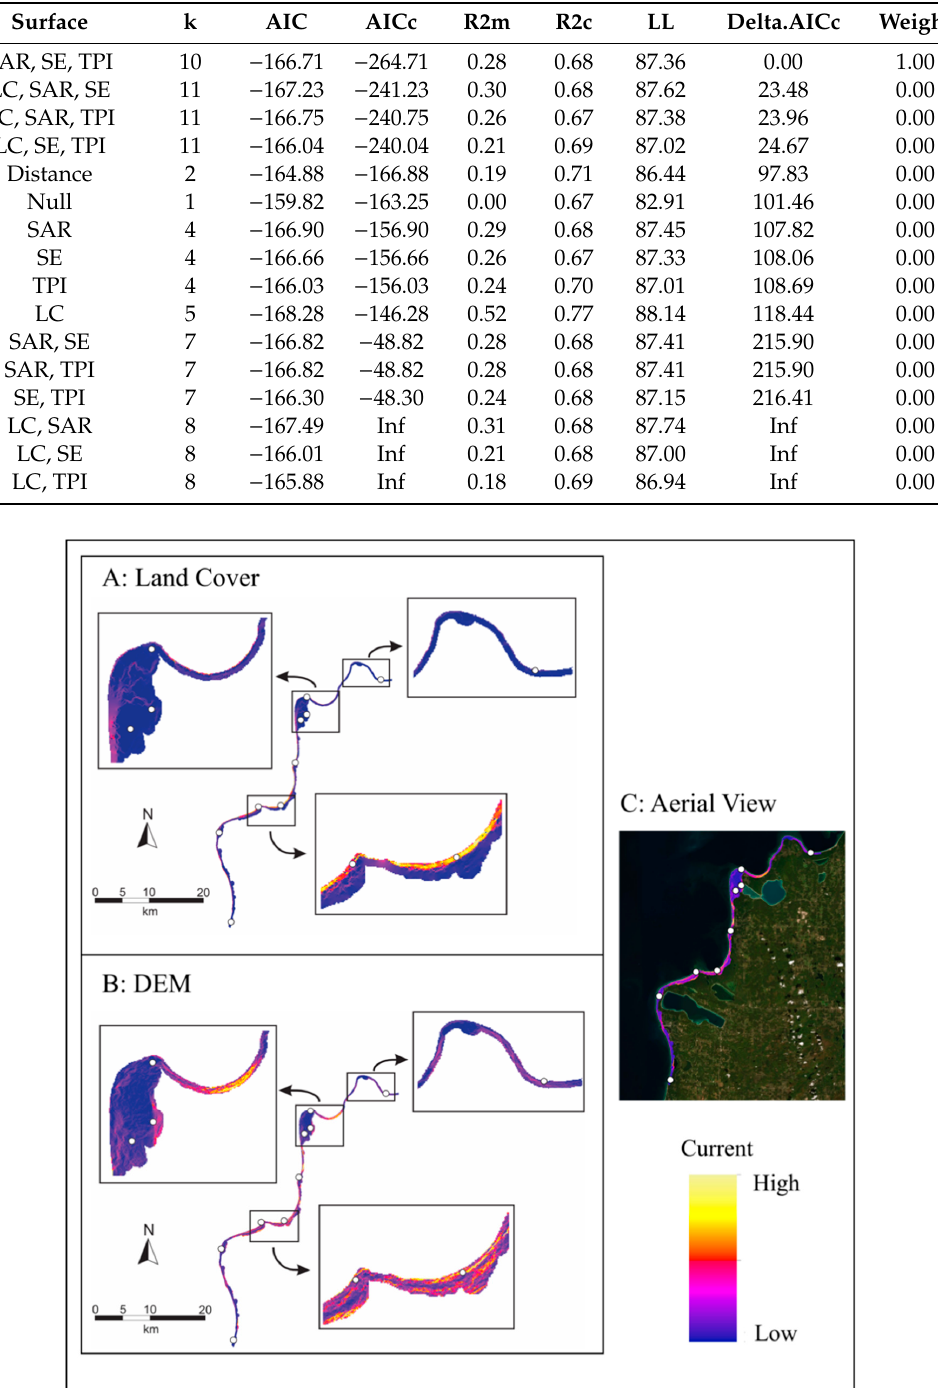
Figure 3. Genetic connectivity map for both ( A ) land cover and ( B ) digital elevation model-based (DEM) optimized resistance surfaces for populations belonging to cluster 2, southwest of the Leelanau Peninsula. Aerial view of the digitized portion is outlined in ( C ). White circles indicate sampling locations, and from north to south, they include Good Harbor Bay (GHB), Sleeping Bear Point (SBP), Dune Climb (DC), Dune Plateau (DP), Empire Bluffs (EB), Platte Bay (PB), South Boundary (SB), Zetterberg Preserve (ZP), and Arcadia Dunes (AD). The color indicates a current gradient, with dark purple indicating low current (high resistance) and yellow indicating high current (low resistance).